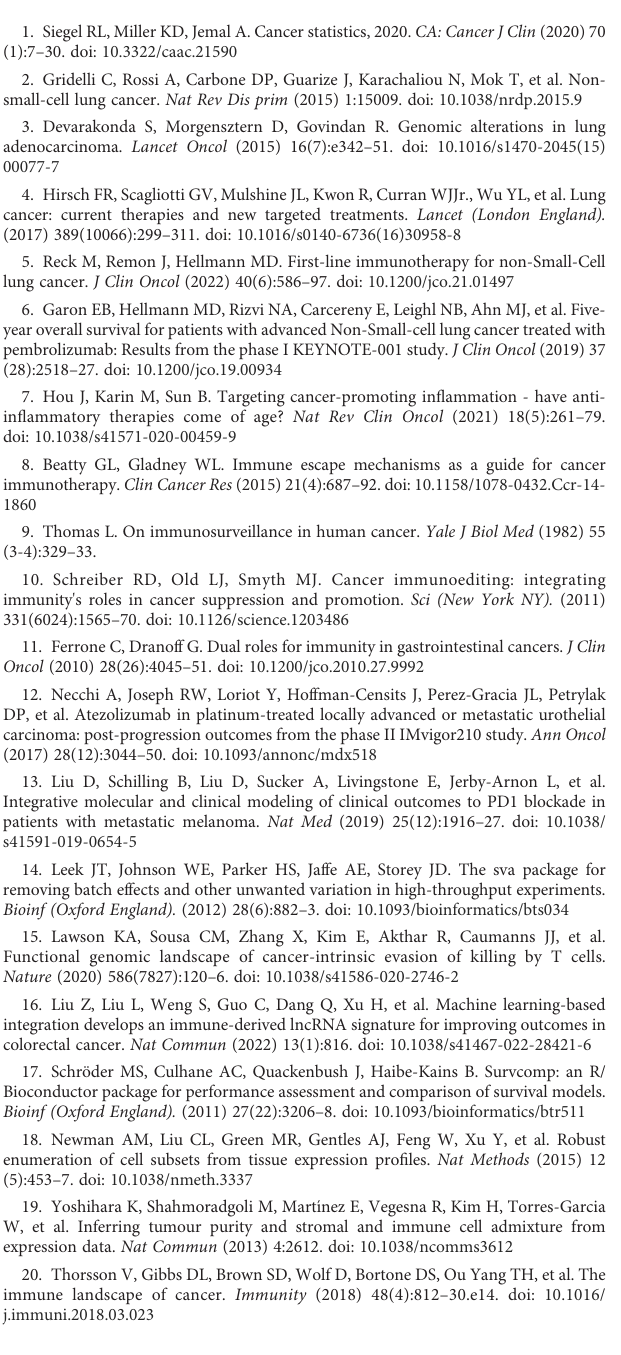
SUPPLEMENTARY FIGURE 1 The TIDE scores in different IERS subgroups (A) TIDE scores in TCGA cohort. (B) TIDE scores in meta-GEO